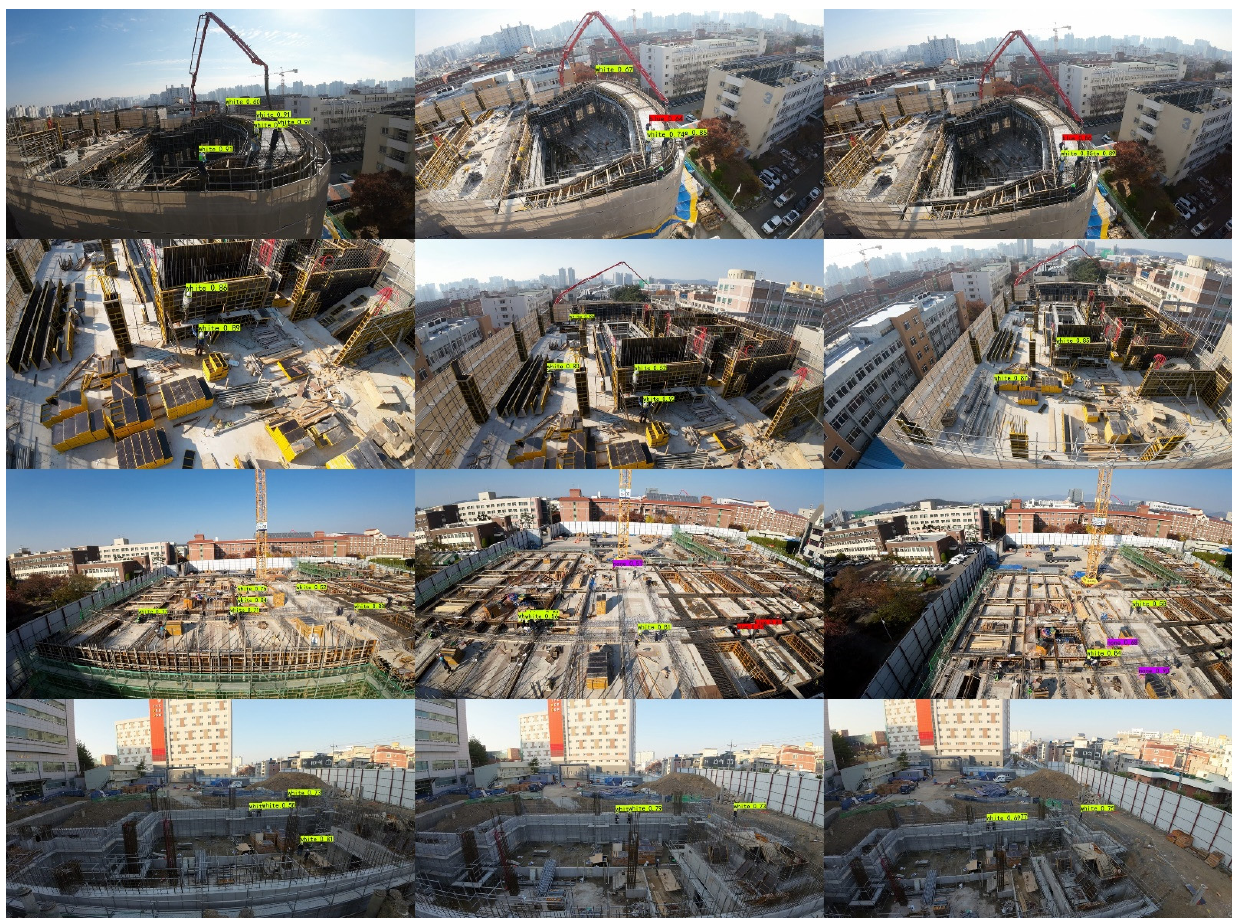
Figure 18. A detection example of the proposed method using a non-maximum suppression method and an IOU of 0.5 to remove redundant bounding boxes. The values on the prediction boxes represent confidence levels, and the text describes their categories. These examples cover the detection conditions of the UAV at different altitudes, representing 5 m, 10 m, and 15 m from left to right.